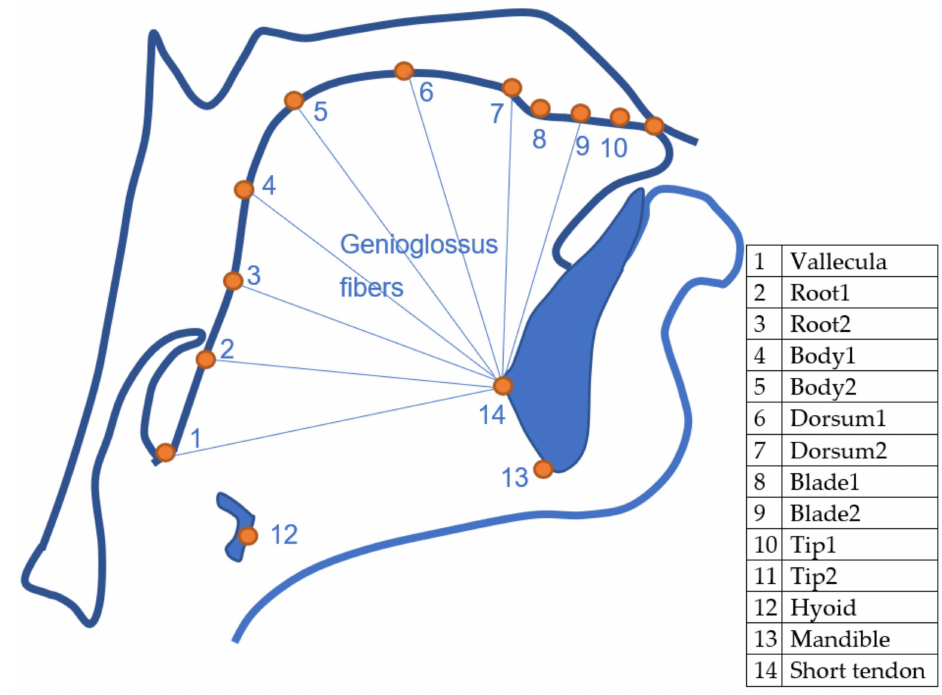
Figure 2. Outline of midsagittal tongue contour and the labelled keypoints.